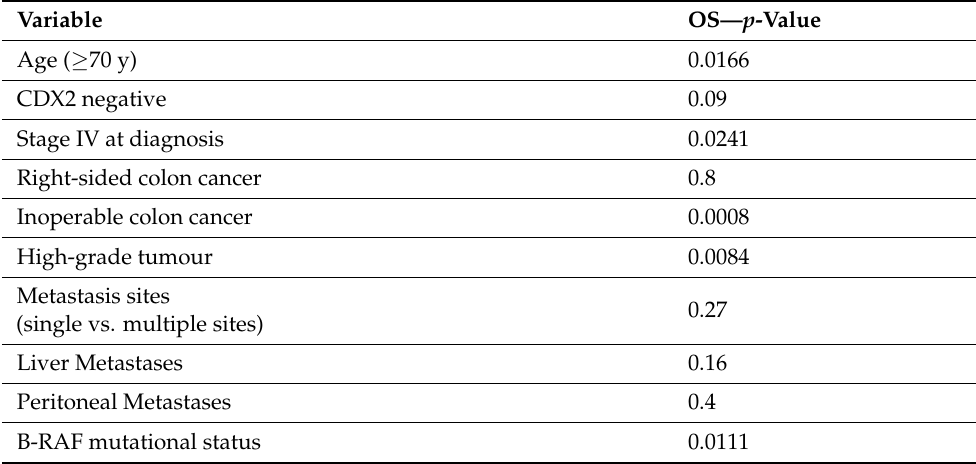
Table 4. Correlation between high CD44 expression and clinically poor prognostic